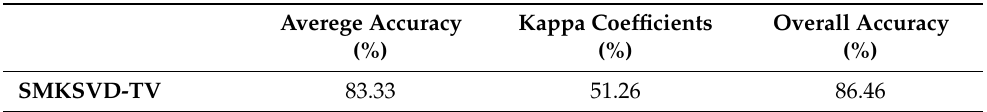
Table 9. SMKSVD-TV results obtained using HYDICE urban hyperspectral data: OA (Overall Accuracy), AA (Average Accuracy+, and Kappa coefficient.